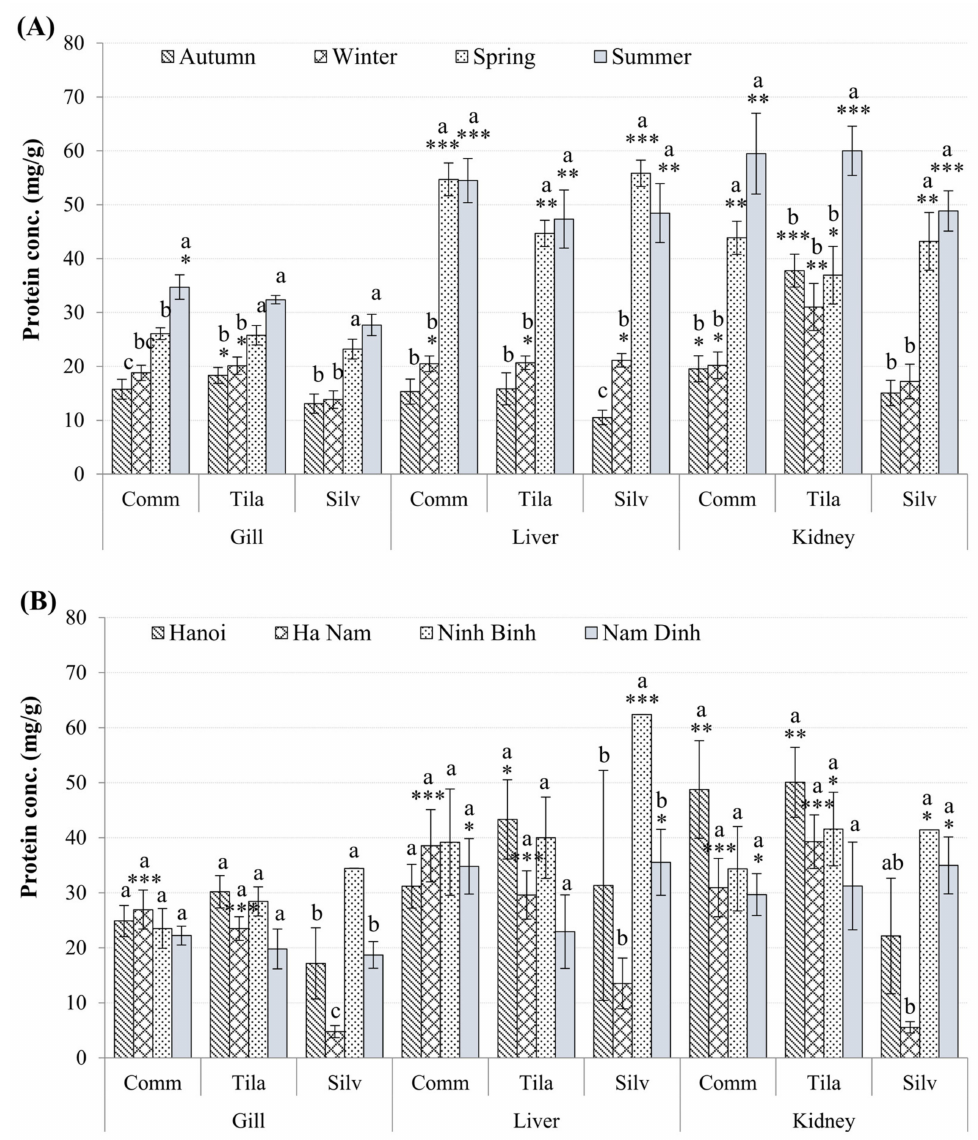
Figure 5. Seasonal and spatial variation in protein concentrations (mean ± SEM) in tissues of the C. carpio (Comm), H. molitrix (Silv), and O. niloticus (Tila) from selected sampling sites. Significant differences in protein levels, of all tissues of three fish species, between sampling times ( A ) and sites ( B ) in comparison to the lowest value (*) are shown (mean ± SEM, n = 10–20, * p < 0.05, ** p < 0.01; *** p < 0.001). Different letters (a > b > c) indicate that the variation of protein values between seasons ( A ) or between locations ( B ) within the same organ type is significant ( p <